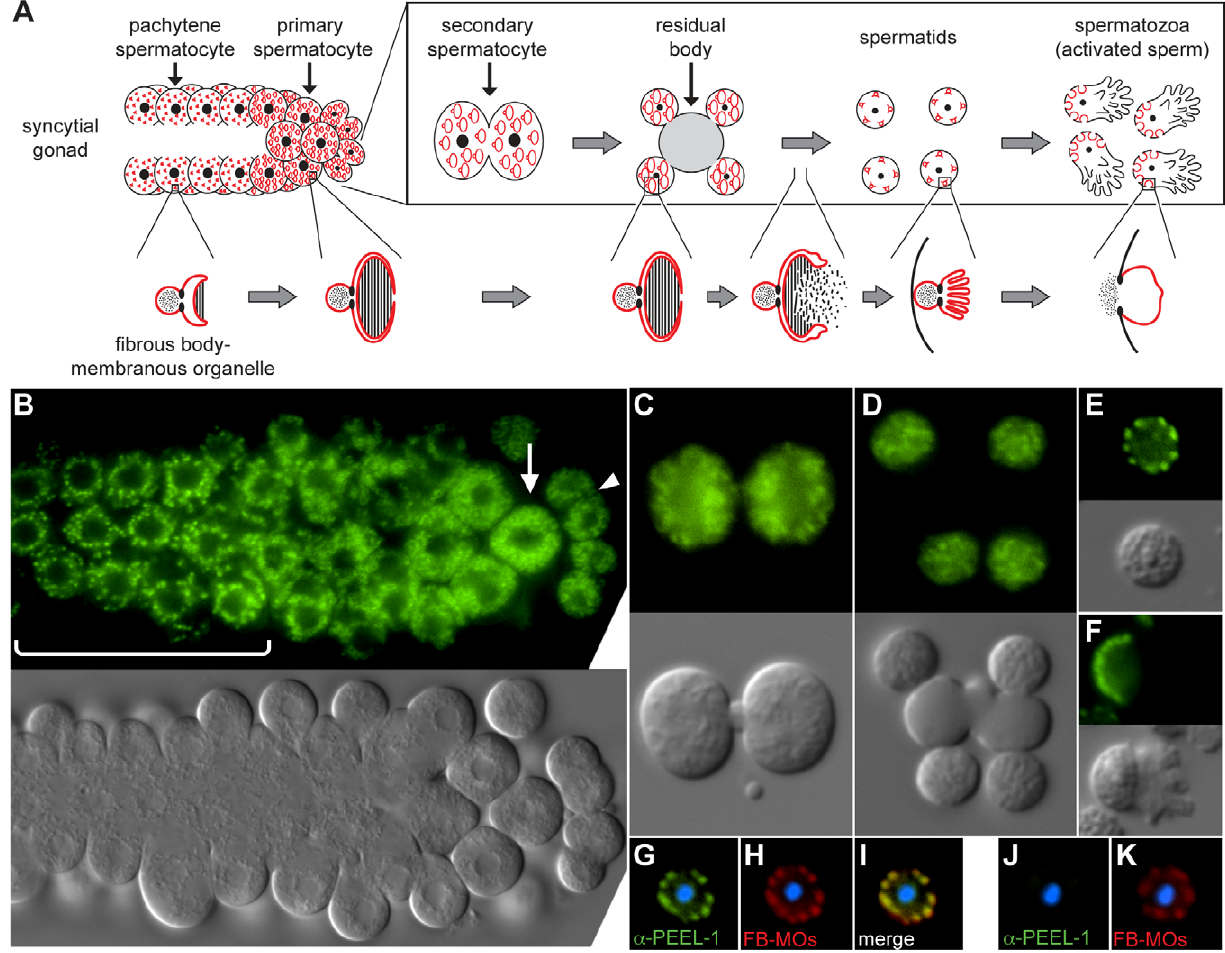
Figure 3. PEEL-1 localizes to fibrous body-membranous organelles. (A) Diagram of spermatogenesis and fibrous body-membranous organelle (FB-MO) development, adapted with permission from [16]. FB-MOs develop in pachytene spermatocytes as membrane-bound organelles having a head region separated by a collar-like constriction from a set of membrane folds (lower panel; red). As spermatogenesis proceeds, the membrane folds grow and extend into arm-like protrusions, enveloping bundles of polymerized Major Sperm Protein, referred to as fibrous bodies (hatched region). Coincident with budding of spermatids from the residual body, the membrane folds of FB-MOs retract, and the fibrous bodies depolymerize into the cytoplasm. The FB-free MOs then move to a position just inside the plasma membrane, and upon sperm activation, they fuse with the plasma membrane opposite the pseudopod. (B–F) Nomarski and fluorescence images of spermatocytes and sperm expressing PEEL-1::GFP . Panels in (B) show the proximal arm of a male gonad, oriented with pachytene spermatocytes towards the left (bracketed region). Arrow and arrowhead indicate primary and secondary spermatocytes, respectively. Panels in (C–F) show higher resolution images of the following stages: secondary spermatocyte (C), budding spermatids (D), unactivated spermatid (E), and activated spermatozoan (F). (G–K) Spermatids were dissected from peel-1( + ) (G–I) or peel-1( D ) (J–K) males and stained with anti-PEEL-1 (green) and the FB-MO marker, 1CB4 (red) [64]. Nuclei are stained with DAPI (blue).